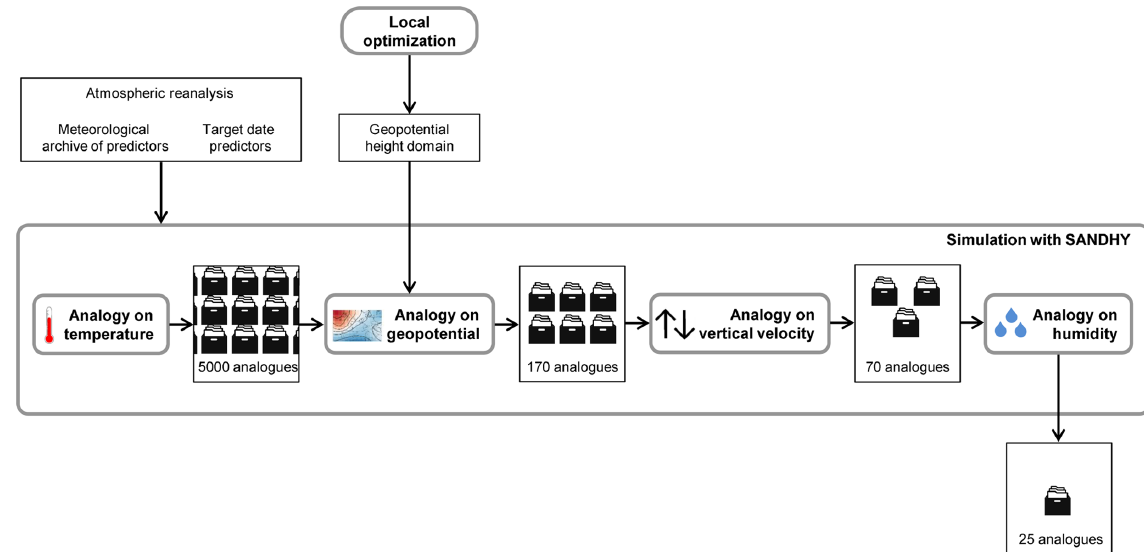
Figure 1. Synthetic diagram showing the sequence of analogy steps in the SANDHY method to reconstruct precipitation and temperature over a given climatically homogeneous zone and for a specific target